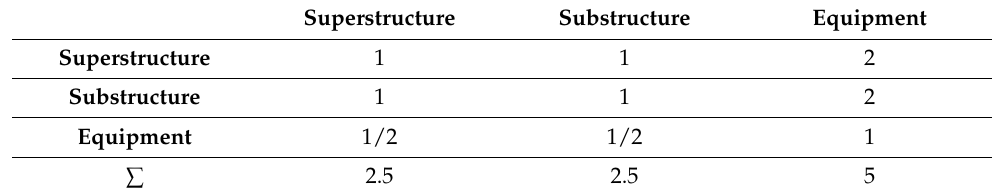
Table 14. Comparison matrix of bridge component.